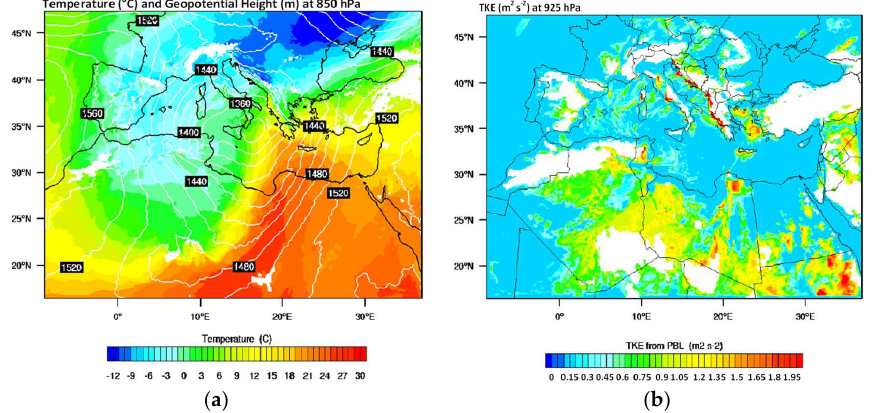
Figure 3. ( a ) Temperature (°C) and geopotential height (white contours every 20 m) at 850 hPa, 22 March 2018, 0600 UTC and ( b ) TKE (m 2 s −2 ) at 925 hPa, 0900 UTC on 22 March 2018; the shaded areas 22 March 2018, 0600 UTC and ( b ) TKE (m 2 s − 2 ) at 925 hPa, 0900 UTC on 22 March 2018; the shaded are mountain tops above 925 hPa. areas are mountain tops above 925